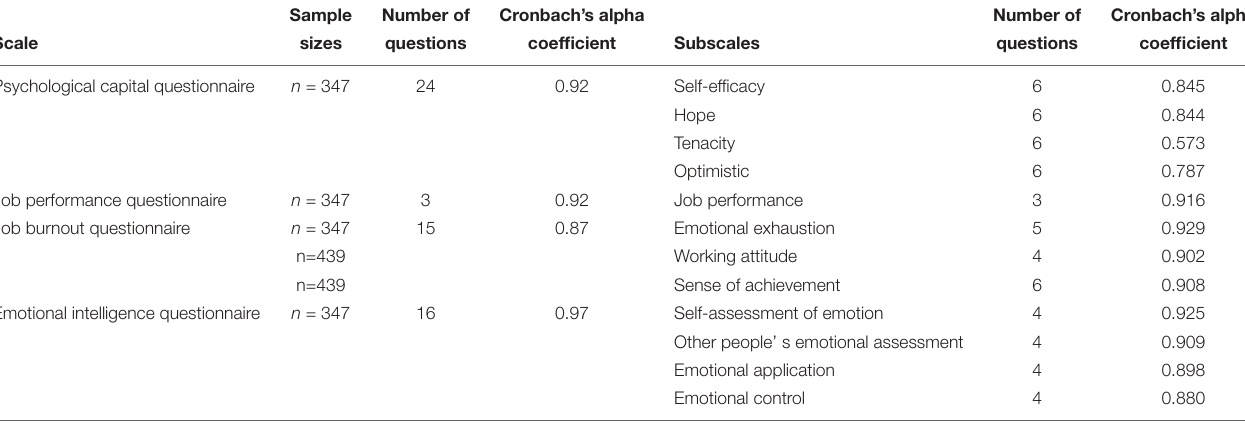
TABLE 1 | Internal consistency reliability results of each questionnaire ( n = 347).